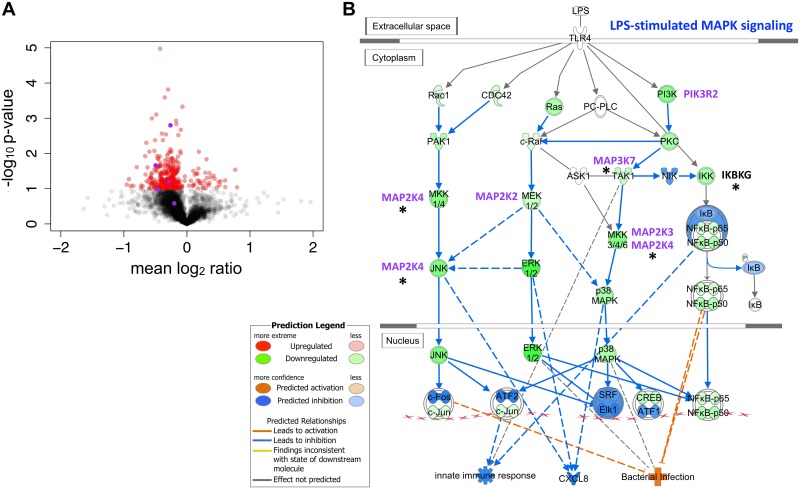
sRNA52320 targets kinases in the LPS-stimulated MAPK signaling pathway and is predicted to attenuate the innate immune response.(A) Volcano plot of -log10 p-values and mean log2 ratios for proteins from LPS-stimulated HBE cells transfected with sRNA52320 compared to LPS-stimulated HBE cells transfected with negative control RNA (siNC). A total of 3902 proteins were identified in all three HBE cell donor samples. Proteins that were differentially expressed (320 total), as determined by a one-sample t-test, are shown as red circles (darker shade indicates higher abundance). sRNA52320 decreased the abundance of the majority of the 320 proteins. (B) The 320 proteins whose abundance was altered by sRNA52320 were analyzed with Ingenuity Pathway Analysis (IPA). The depicted IPA canonical pathway “LPS-stimulated MAPK signaling” was one of the top 10 canonical pathways identified (p = 0.005, activation z-score = -2.236). The green circles identify proteins whose abundance was reduced by sRNA52320 compared to siNC. Five kinases in the LPS-stimulated MAPK signaling pathway were predicted to be direct targets of sRNA52320, including MAP2K2, MAP2K3, MAP2K4, MAP3K7, and PIK3R2 (indicted by purple text). *denotes significantly decreased protein abundance by sRNA52320 (p < 0.05). Blue shading indicates predicted inhibition and orange shading stands for predicted activation.